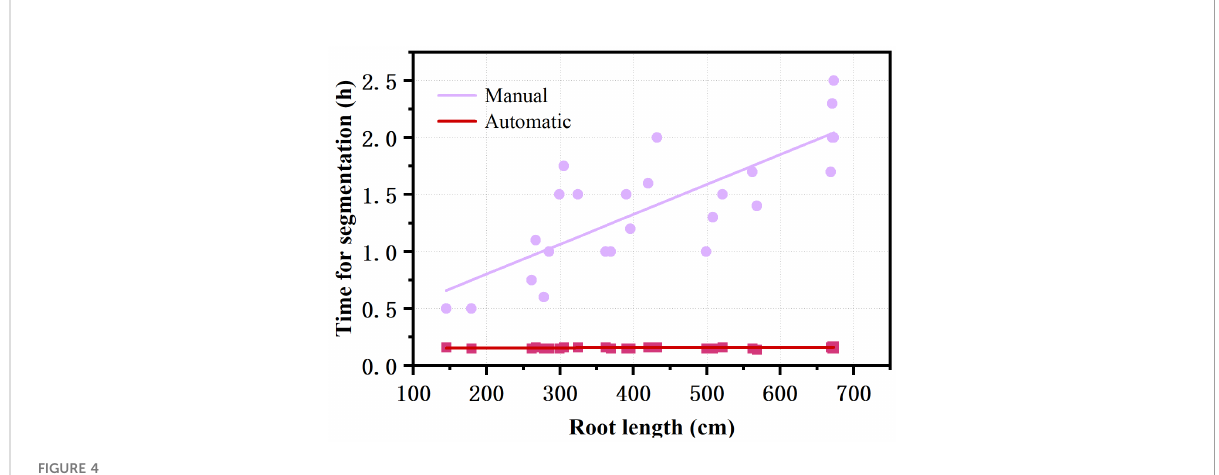
FIGURE 4 Comparison of the ef fi ciency of automatic segmentation and manual segmentation of images with different root lengths.